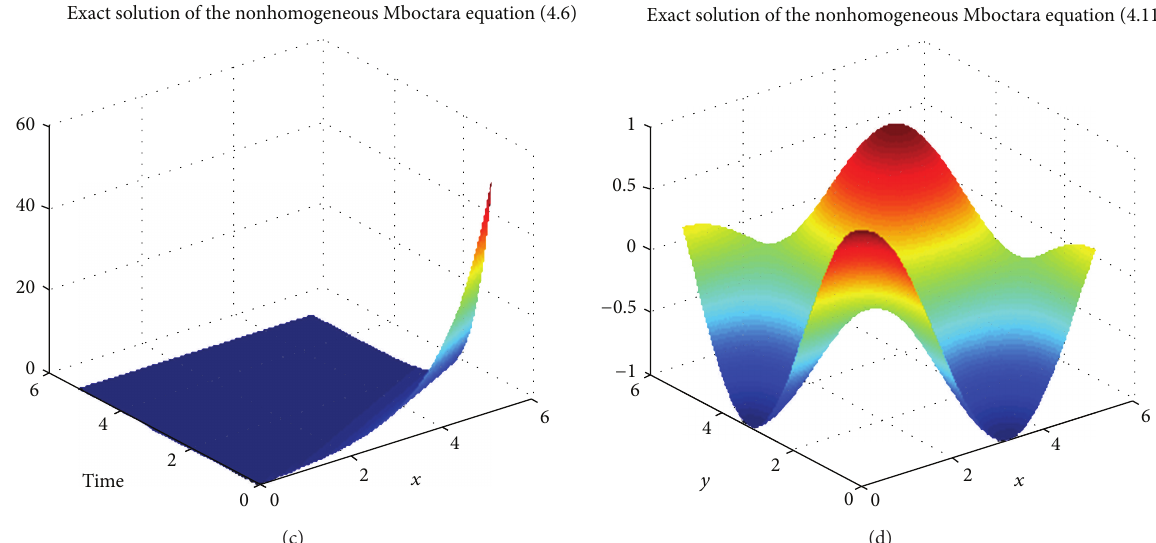
Figure 1: Numerical simulation of the exact solutions of the Homogeneous and non-homogeneous Mboctara